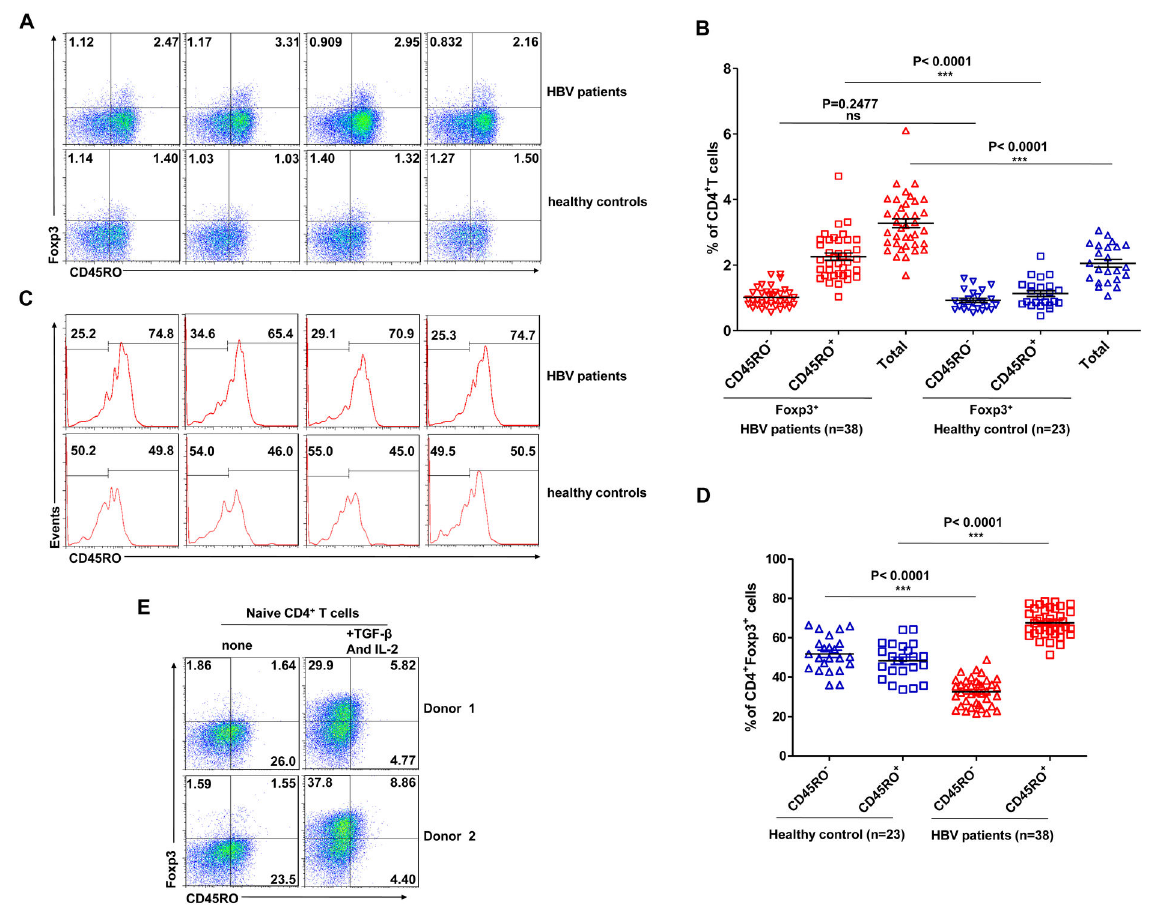
Figure 1. Differential CD45RO expression between Foxp3 + T cells differentiated in vivo by chronic viral infection and in vitro by TCR stimulation. (A) Flow cytometric analysis of Foxp3 expression by CD4 + PBMCs of 4 HBV-infected patients (upper panels) and 4 healthy controls (lower panels). The frequency of cells in each quadrant is displayed as numbers in the quadrants. (B) The average percentages of CD45RO + Foxp3 + , CD45RO - Foxp3 + and Foxp3 + cells in the pools of CD4 + cells from 38 HBV-infected patients and 23 healthy controls. (C) Flow cytometric analysis of CD45RO expression by CD4 + Foxp3 + PBMCs of 4 HBV-infected patients (upper panels) and 4 healthy controls (lower panels). The frequency of cells in each quadrant cells is displayed as numbers in the quadrants. (D) The average percentages of CD45RO + and CD45RO - cells among pools of CD4 + Foxp3 + cells from 38 HBV- infected patients and 23 healthy controls. (E) Naive CD4 + T cells were sorted from adult peripheral blood by FACS, and the cells were activated with plate-bound anti-CD3 (5 μg/ml) and soluble anti-CD28 (1 μg/ml) in the absence or presence of TGF-β (5 ng/ml) and IL-2 (100 UI/ml) for 5 days. The cells were then collected and analysed by flow cytometry to evaluate the expression of Foxp3 and